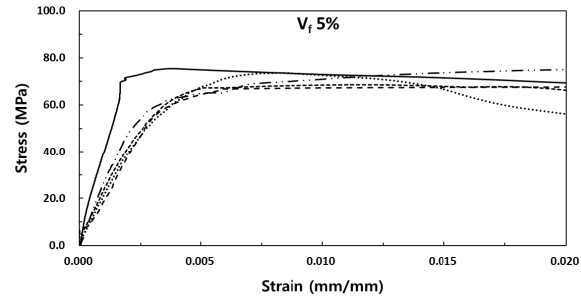
Figure 9. Stress-strain curve for the fiber volume fraction of 5%.